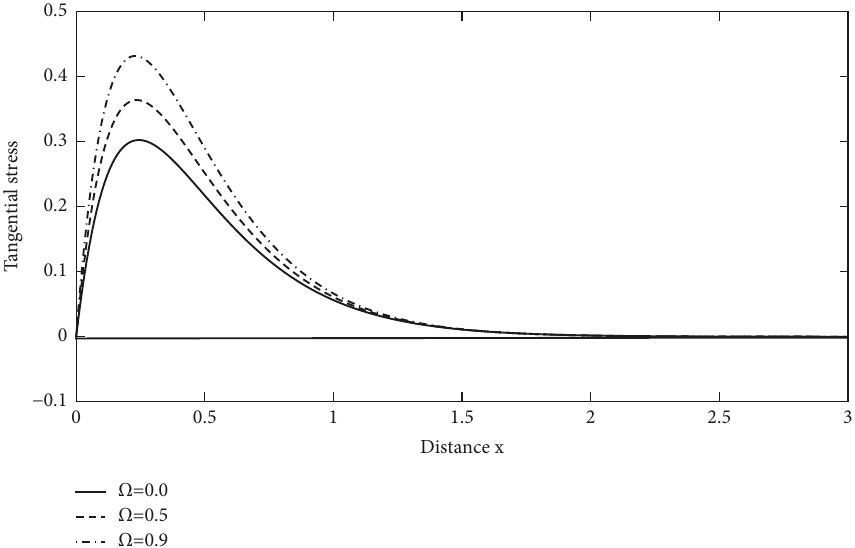
Figure 4: Effect of angular velocity on tangential stress distribution.